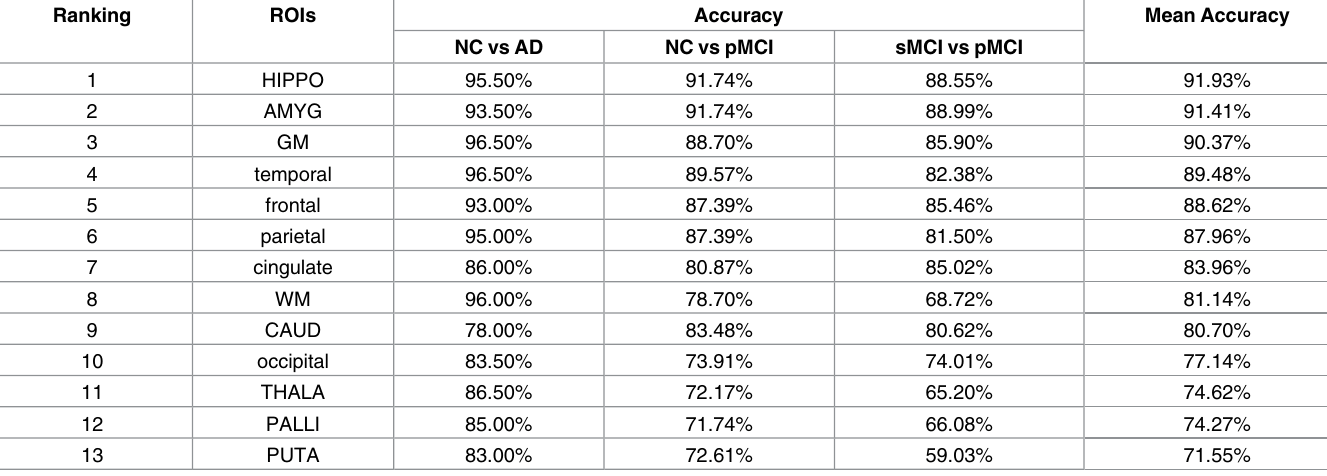
Table 5. Classification performance comparison for different ROIs.